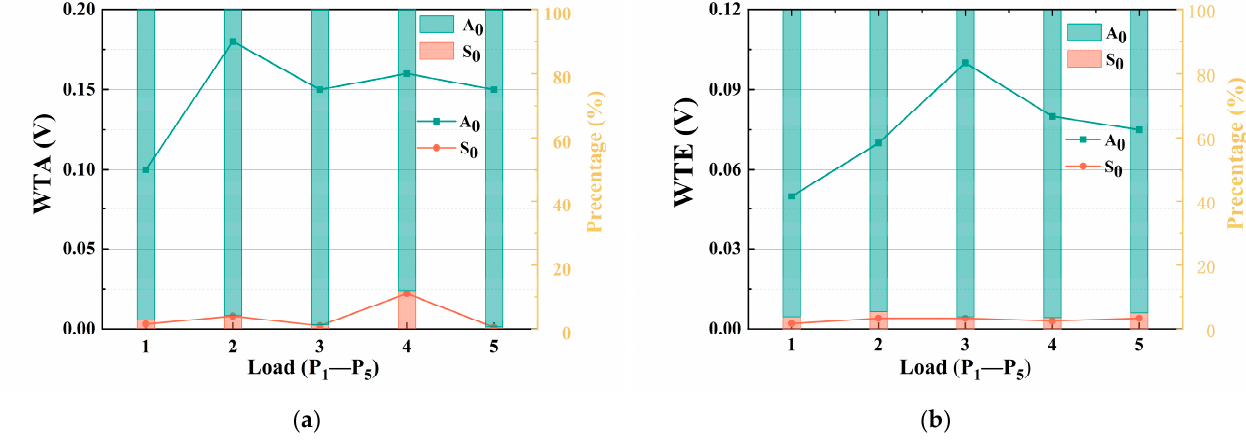
Figure 8. Waveform diagrams of specimens in different load modes: P 1 –P 5 stages ( a – e ).